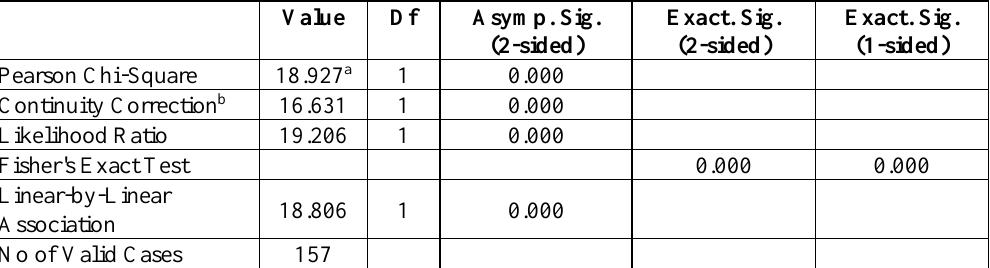
Table 5. Chi-Square Analysis of the Relationship between the Level of Awareness of Building Commissioning Practice and Its Adoption (developed by the authors) Value Df Asymp. Sig. Exact. Sig. Exact. Sig. (2-sided) (2-sided)